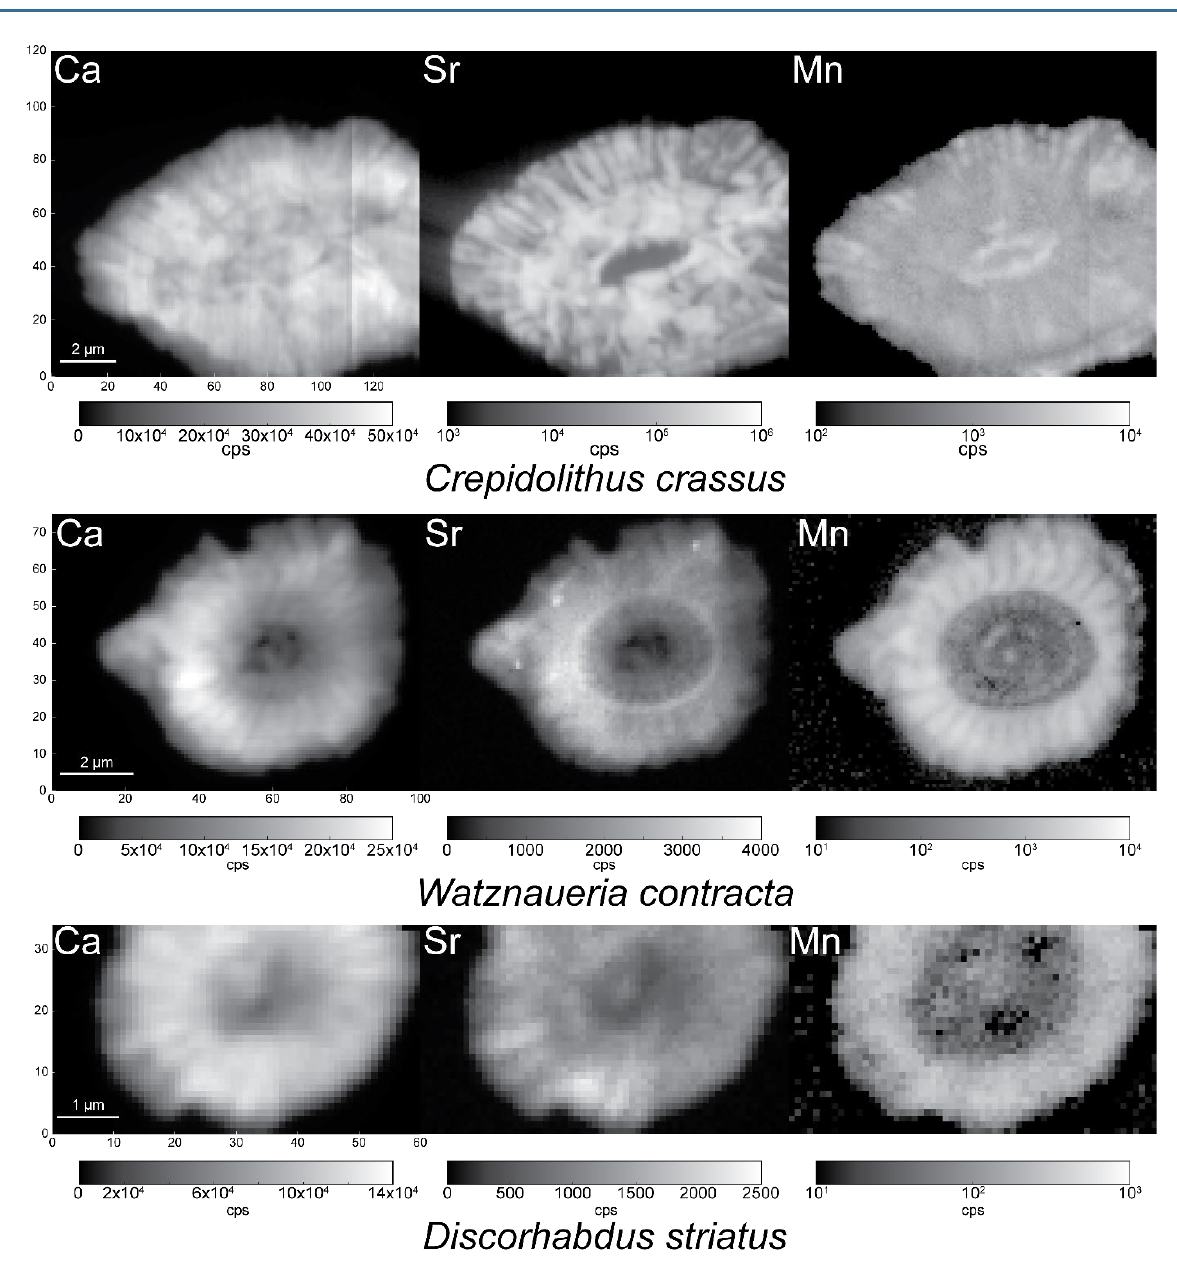
Figure 2. Ca, Mn and Sr maps (cps) of C. crassus , D. striatus and W. contracta .